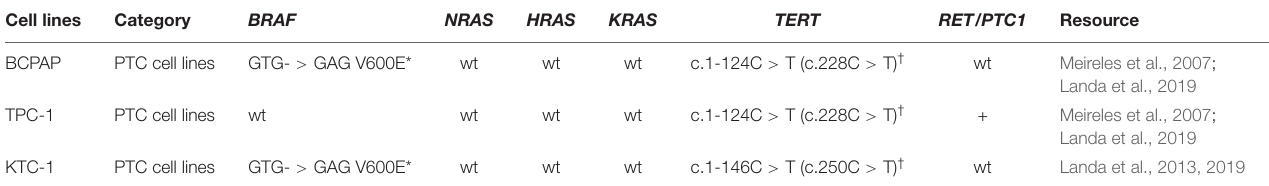
TABLE 3 | Genotype of the employed PTC cell